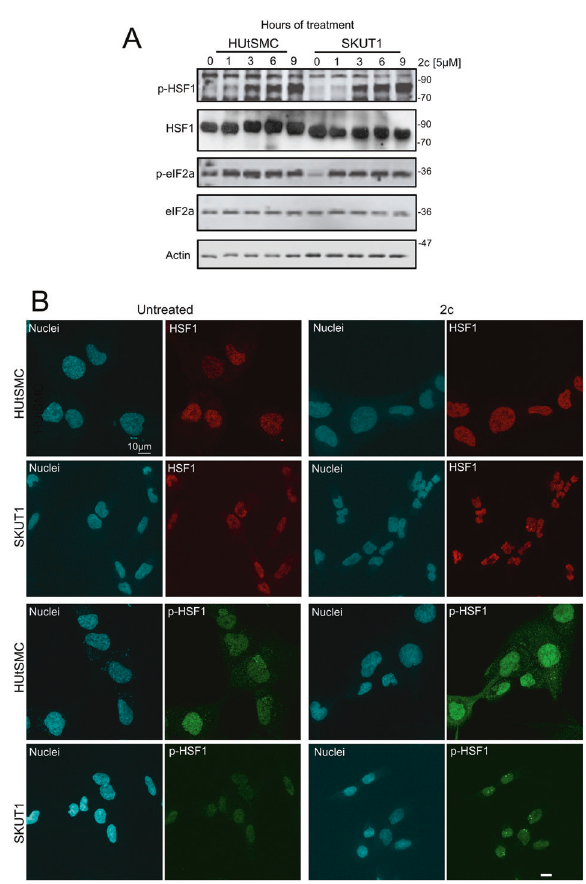
Fig. 4 Regulation of HSF1 during 2c-induced proteotoxic stress between non-transformed and cancer cells. A Cells were treated for the indicated times with 2c (5 µmol/L). Immunoblots were performed using the indicated antibodies. Actin was used as a loading control. B Cells were treated or not with 5 µmol/L of 2c for 3 h. Immuno fl uorescence analysis was performed to visualize HSF1 and HSF1 phosphorylated at Ser 326. Nuclei were stained with Hoechst 33342. Confocal images are shown in pseudocolors. Bar 10